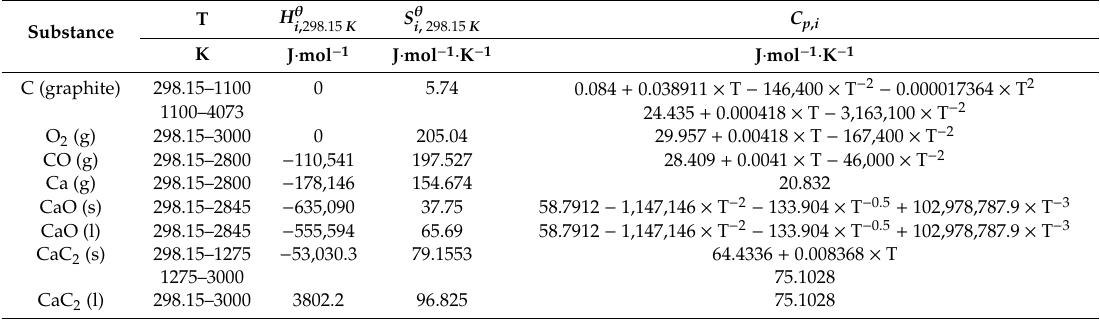
, S θ and C p , i of the components in the i ,298.15 K i ,298.15 K